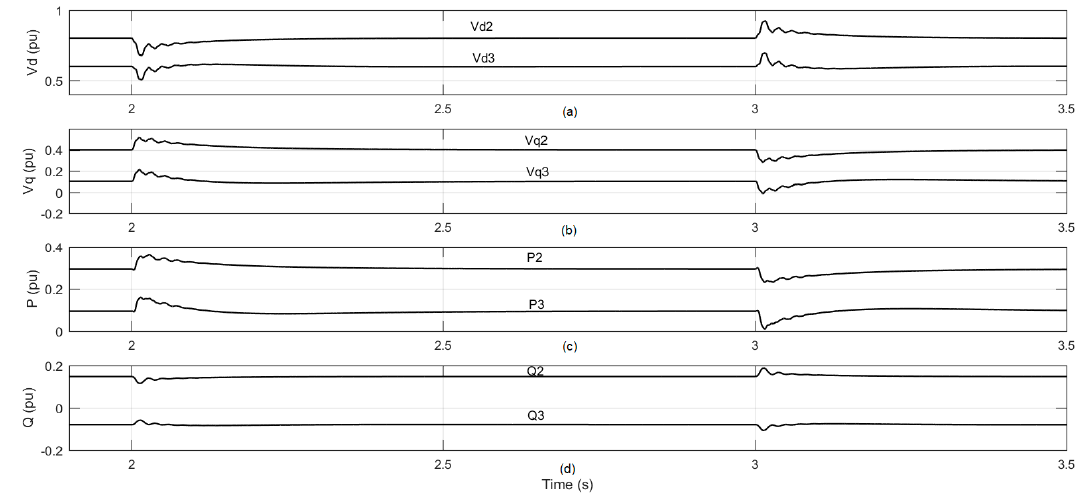
Figure 5. Dynamic performances of DGs 2 and 3 as a result of two-step changes in V dq1 set point. ( a ) d-component of the load voltages at PCs. ( b ) q-component of the load voltages at PCs. ( c ) Output active power of DGs. ( d ) Output reactive power of DGs.